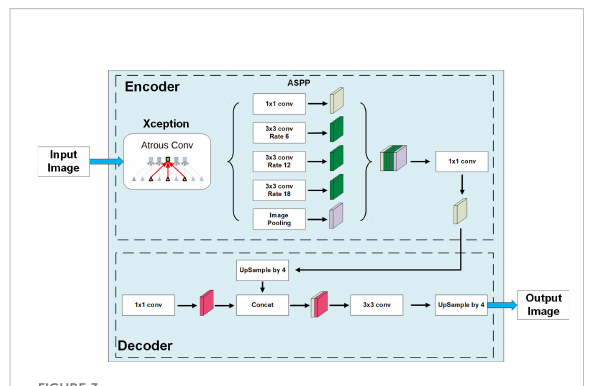
FIGURE 3 The model structure of DeepLabV3+ with the Xception